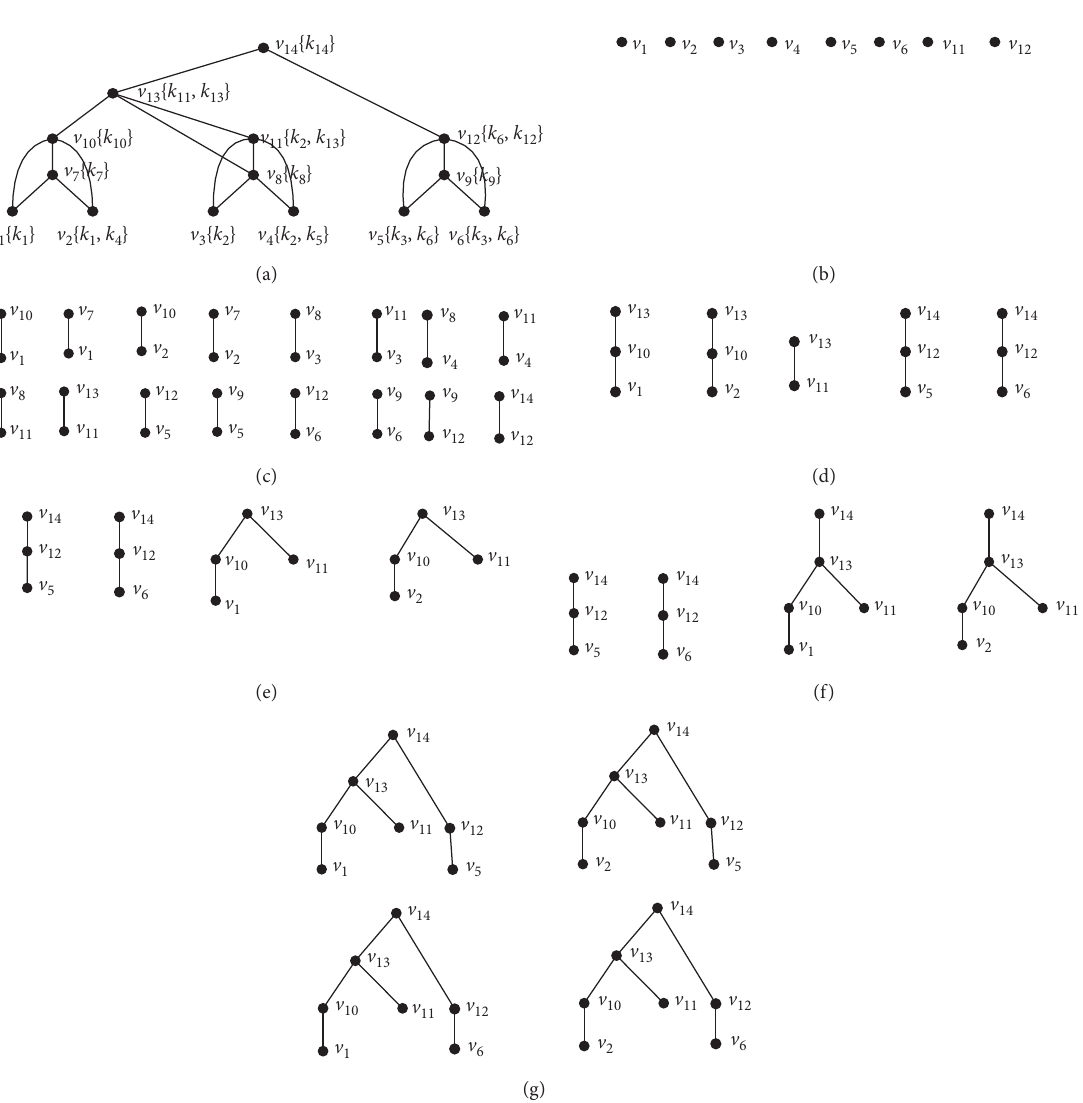
Figure 7: An example of T ( Q ) generation